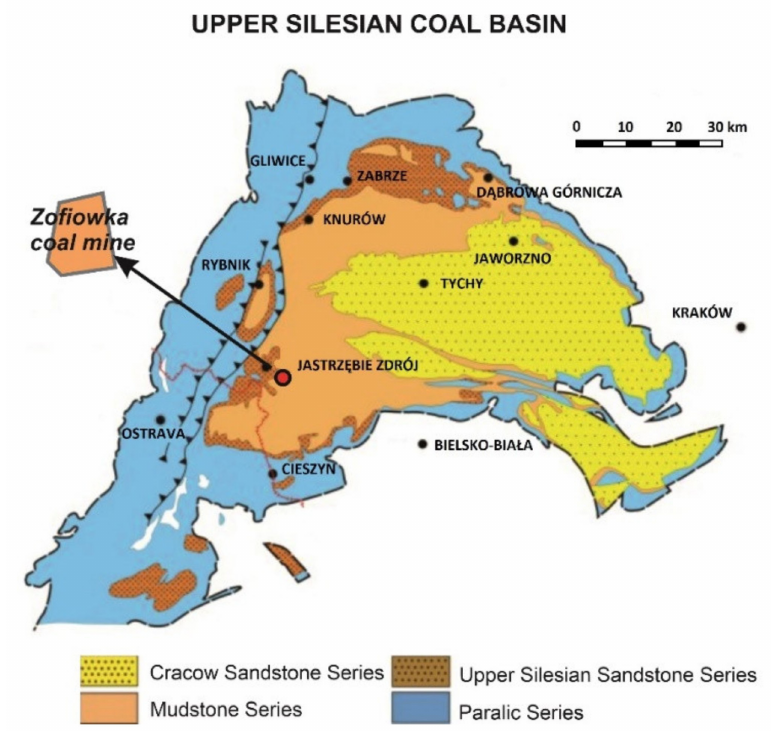
Figure 1. Location of the Zofi ó wka Mine mining area as the sampling area